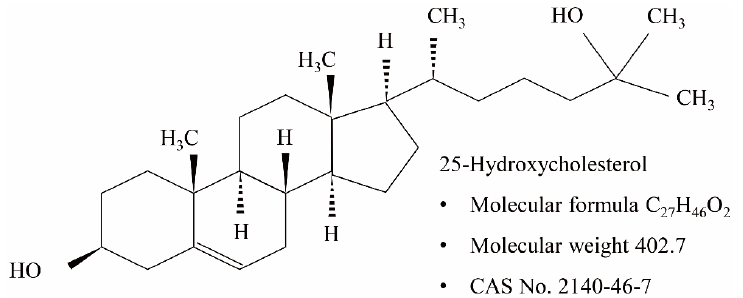
Figure 1. Chemical structure of 25-hydroxycholesterol.